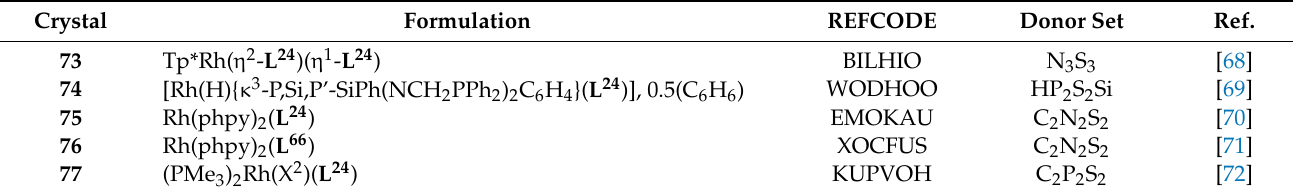
Table 3. Summary of rhodium dithiocarbamate structures established by X-ray crystallography. See Table 1, Figure 2, and the Abbreviations